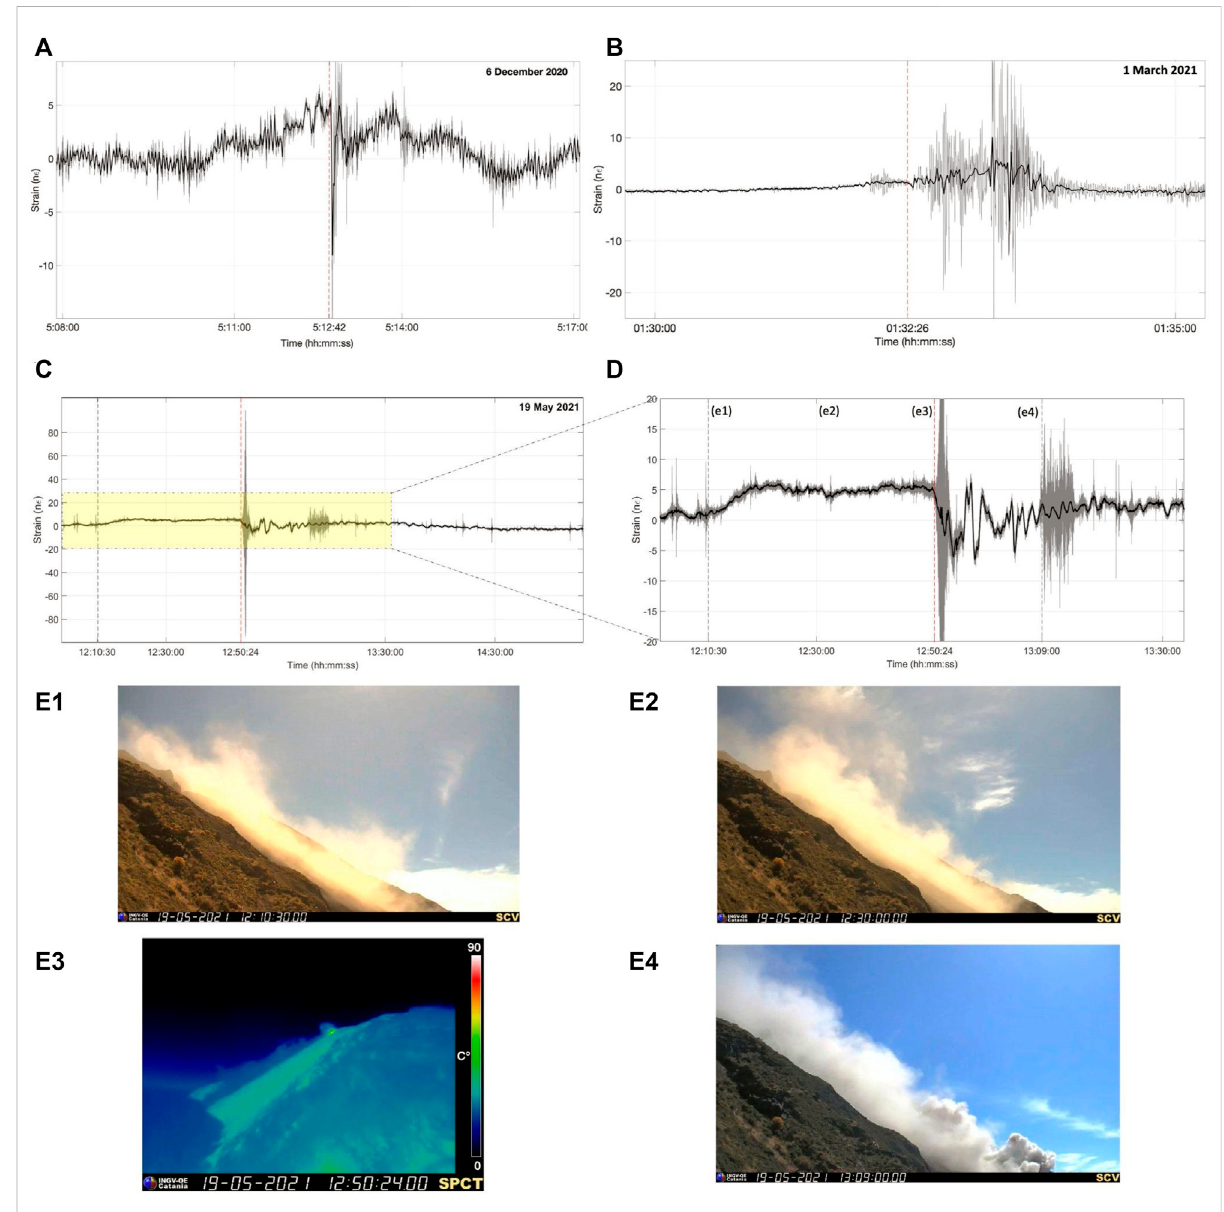
FIGURE 6 Strain recorded at the SVO station during the three major explosions listed in Table 1: (A) event occurring on 6 December 2020; (B) event on 1 March 2021; (C) event on 19 May 2021. Gray plots represent the 50-sps strain data, whereas black plots are the same data sampled at 1 s. (D) Magni fi edinset ofthe19 Mayeventwhere therecordedstrain variation isclearlyvisible beforethephenomenology. (E1,E2andE4) visibleSCV (view from NE) and thermal SPCT [ (E3) , view from NW] camera frames recorded at 12:10:30, 12:30:00, 13:09:00 and 12:50:24 respectively, in correspondence with the strain changes depicted in (D)